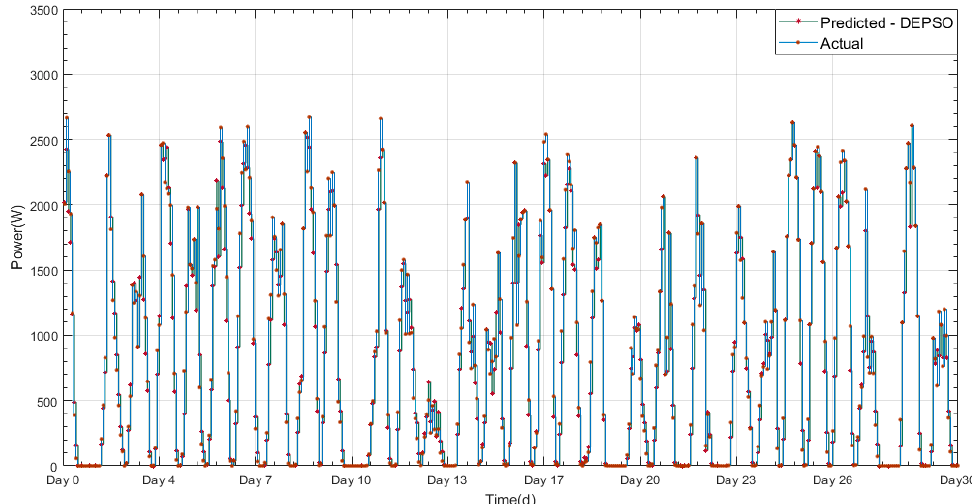
Figure 17. DEPSO-forecasted and actual values of PV output power.